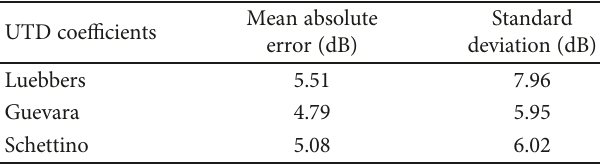
Figure 18: Path loss comparison of model and measured data (red line) for Queen St. Table 5: Statistics of the path loss for Ottawa City. Bank St. UTD coe ffi cients